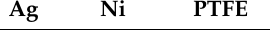
Table 2. Composition of processed ODCs used for leaching trials.